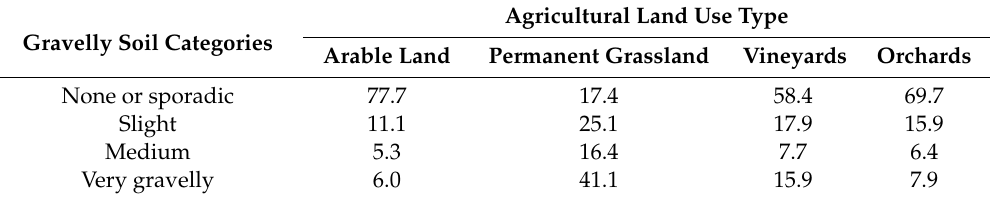
Table 8. Share of soil depth categories (%) in agricultural land use types in Slovakia. Soil Depth